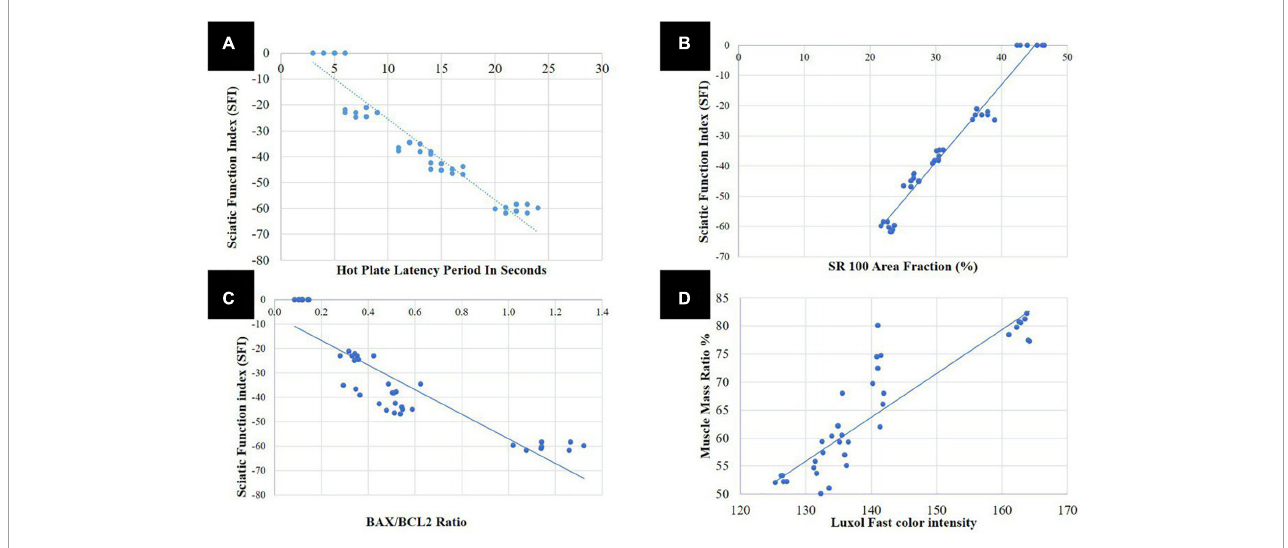
FIGURE9 Correlation analysis; (A) between sciatic function index (SFI) and hot plate latency period in seconds, (B) between SFI and S100 area fraction, (C) between SFI and BAX/BCL2 ratio, and (D) between area percentage of gastrocnemius muscle fibers and Luxol fast color intensity